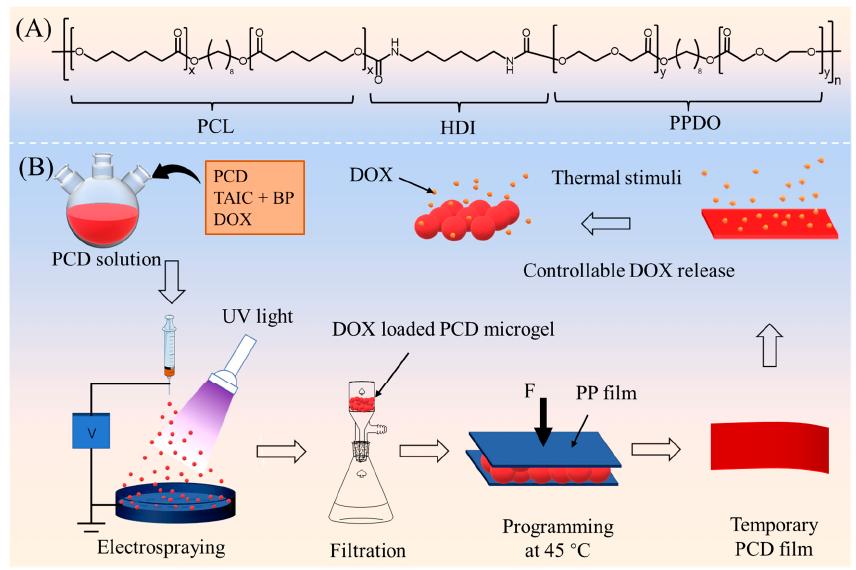
Figure 1. The chemical structure of PCD ( A ) and the scheme of the temporary film prepared from the electrosprayed shape-memory microgels ( B ).